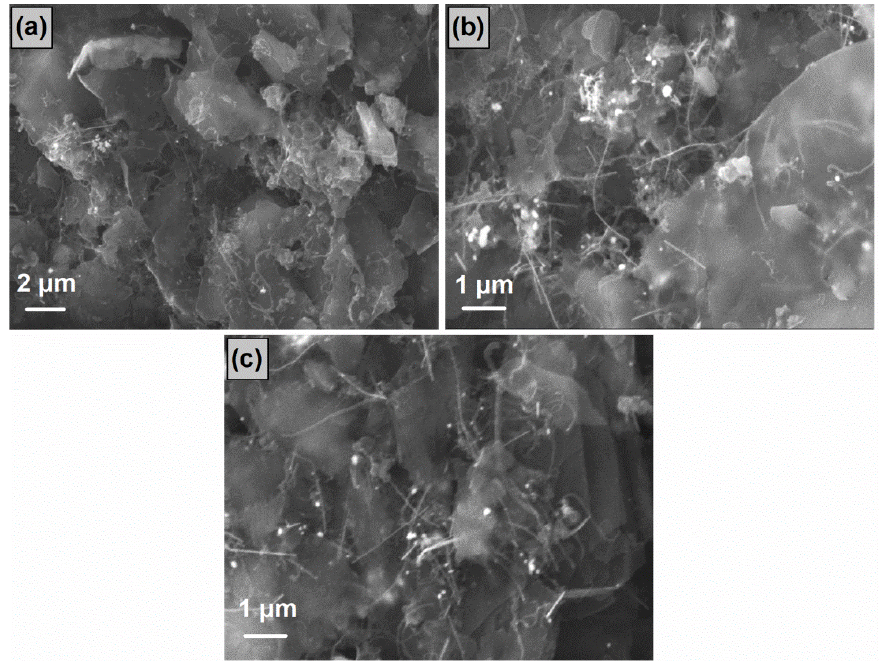
Figure 4. SEM images of FLG/MWNT- f -OH/AgNWs nanohybrids with ( a ) 10, ( b ) 30, and ( c ) 50 wt % AgNWs.